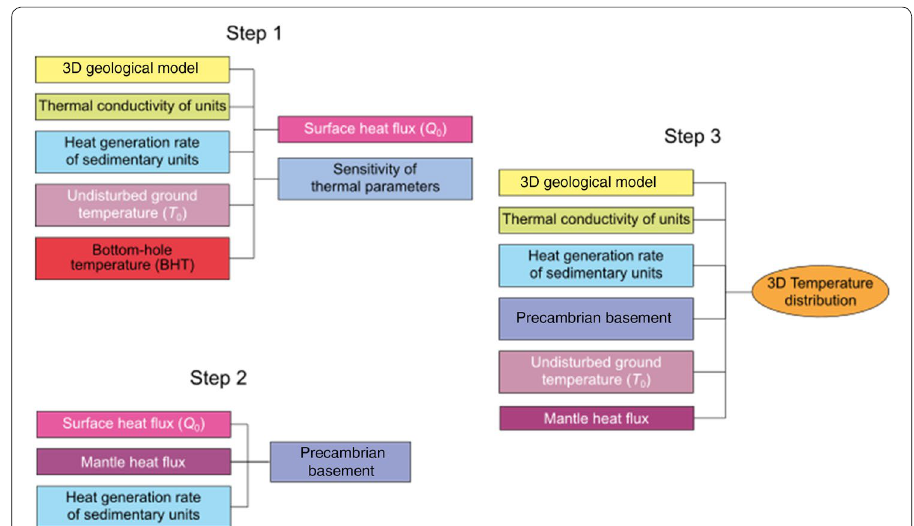
Fig. 3 Workflow for the modeling of 3D temperature